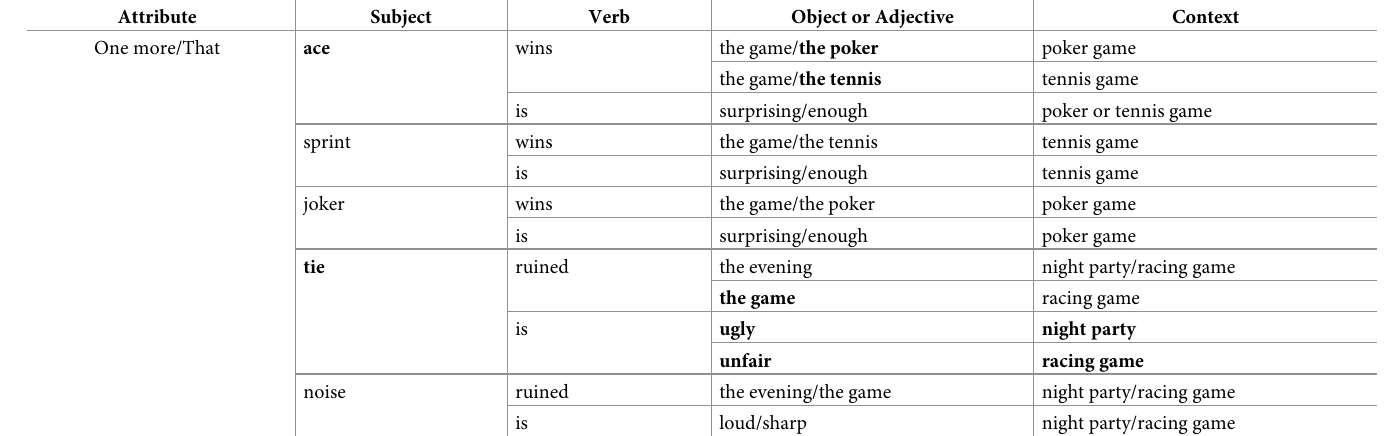
Table 2. All possible sentences in the model.